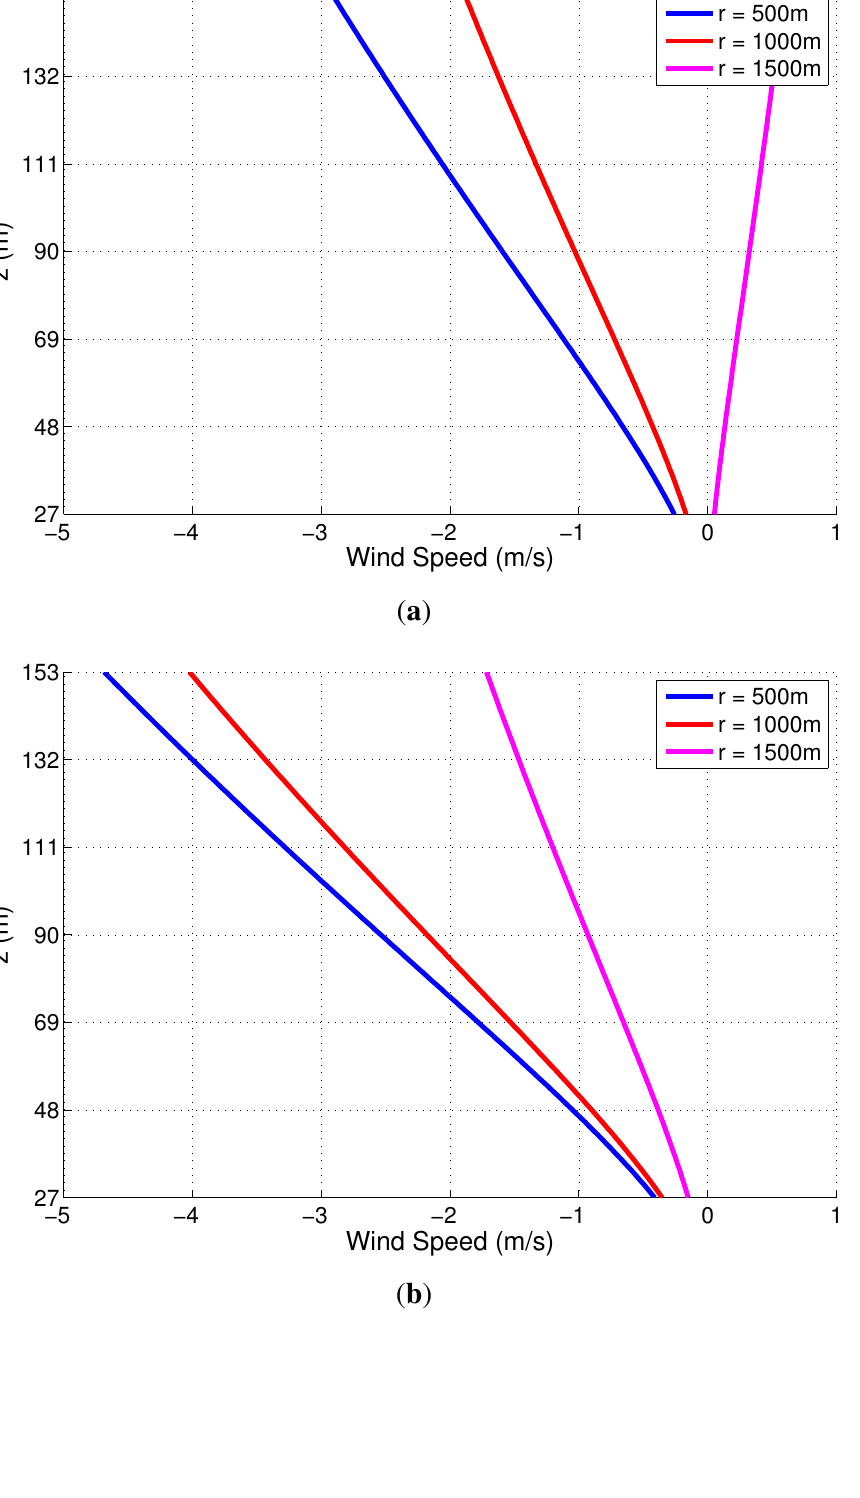
/ 6 when the storm d / 2 when the d